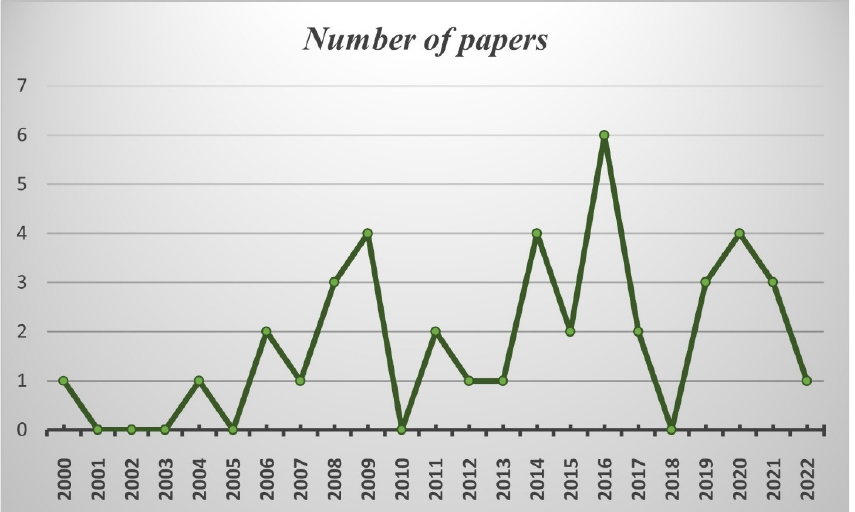
Figure 2. The trend of published articles based on publication year. The sources for the search of works reviewed were the following databases: Scopus (Elsevier), Google Scholar, and Web of Science (Clarivate Analytics). The x-axis shows the years of the period under consideration, while the y-axis shows the number of searches carried out. The researches considered are those carried out from the beginning of the year 2000 until the end of March 2022.